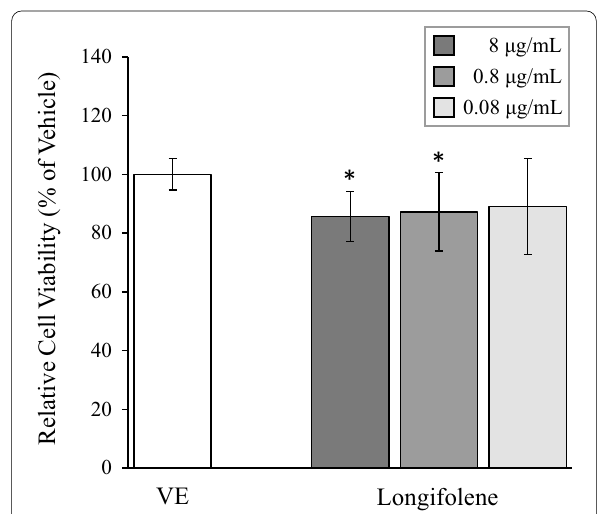
Fig. 6 Effect of longifolene on cell viability. VE: vehicle, DMSO. The results are presented as mean compared to